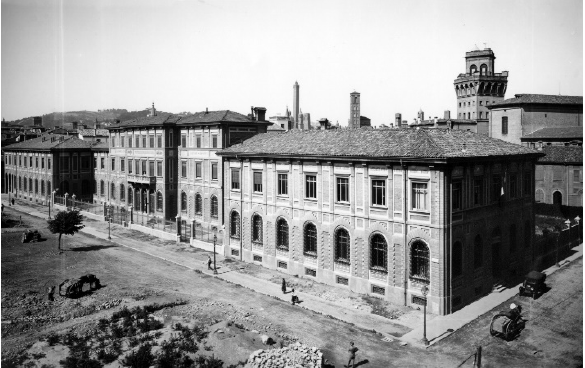
Figure 2. Main façade of the G. Ciamician Institute on